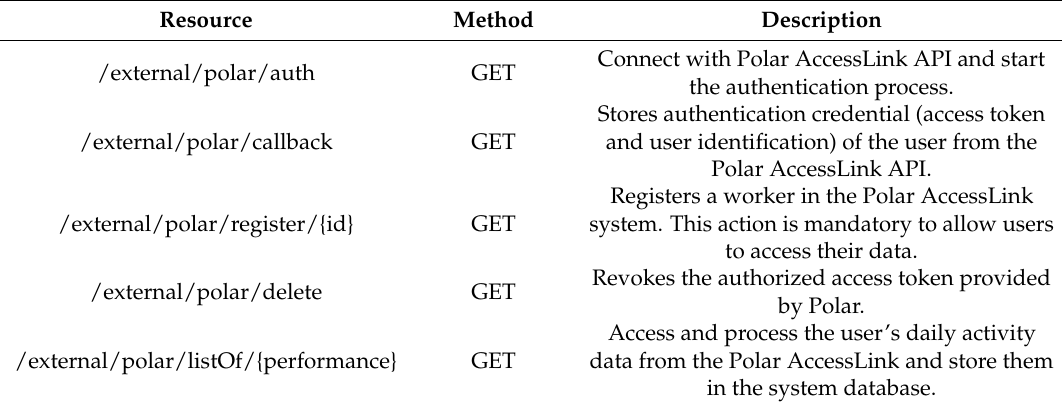
Table 5. Resources provided by the External Communication Module.